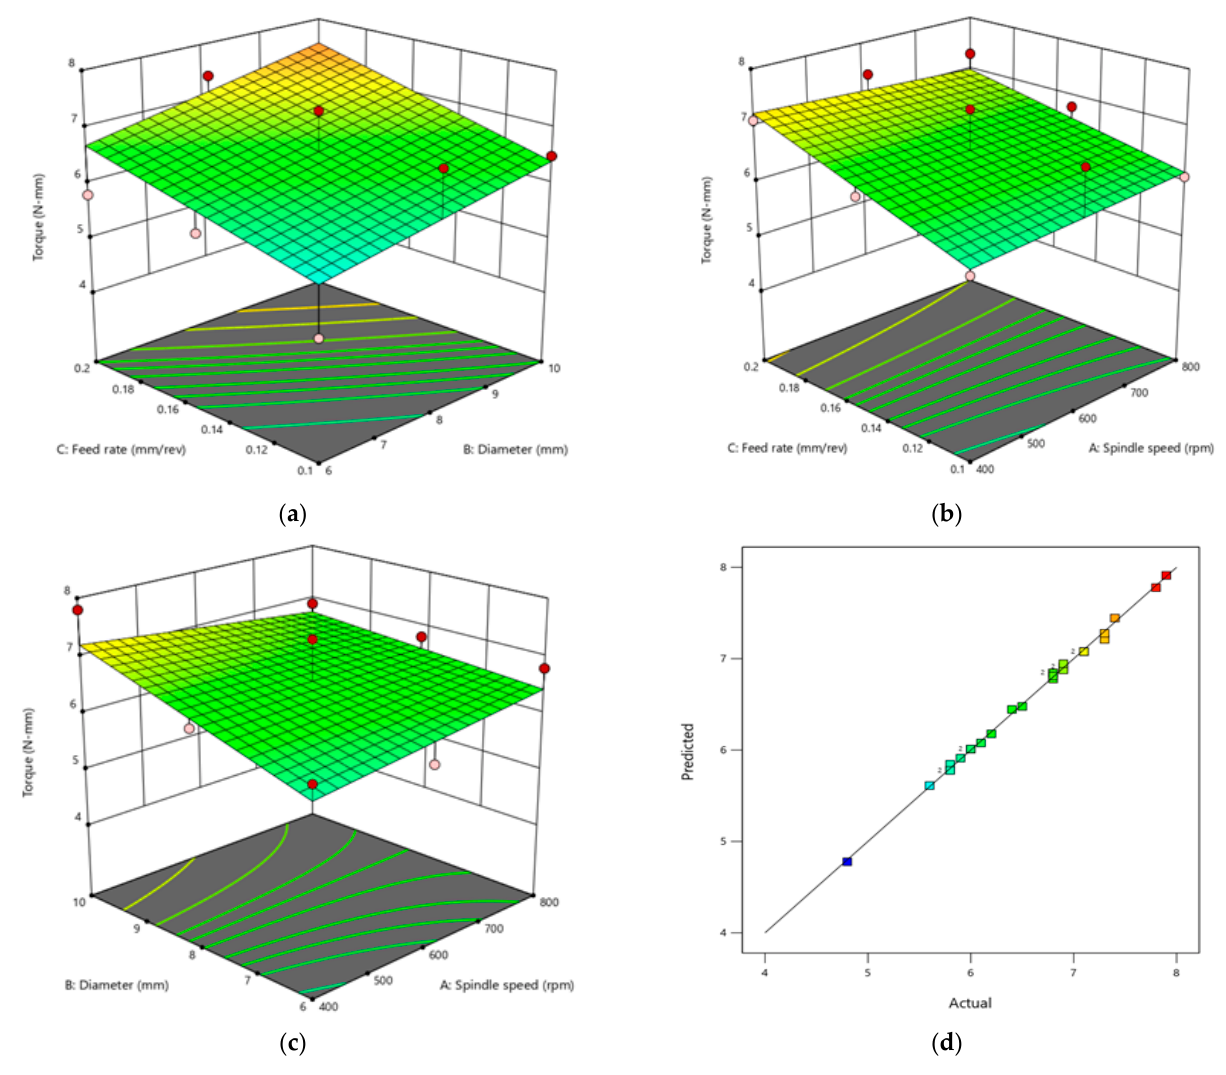
Figure 12. ( a ) The interaction between feed rate and diameter. ( b ) The interaction between feed and spindle speed. ( c ) Spindle speed and diameter interaction. ( d ) Actual vs. predicted torque. The regression models for thrust force and torque are presented in Equations (3) and (4).